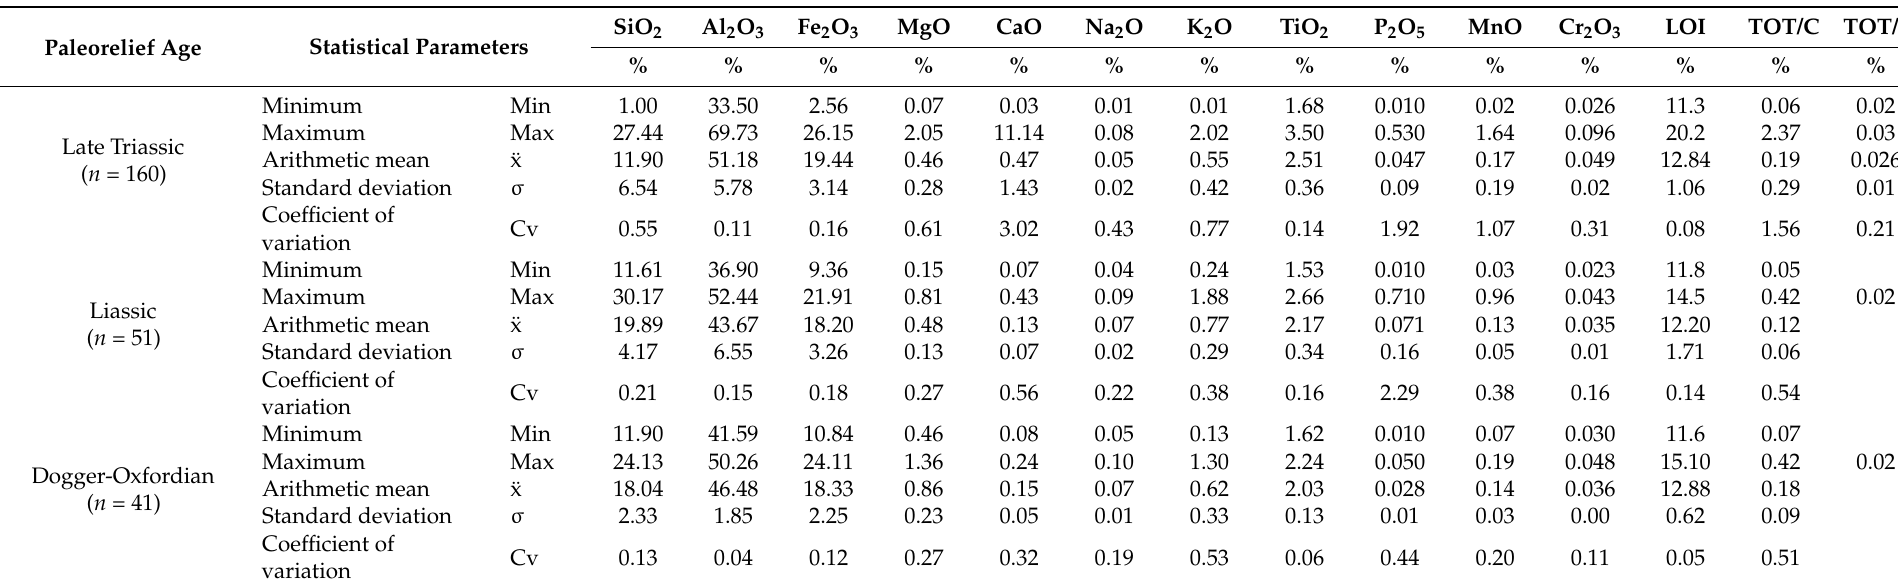
Table 9. Statistical parameters of geochemical analyses of major oxides in Jurassic bauxites of the Vojnik-Maganik and Prekornica ore regions (after Radusinovi´c [5]). Paleorelief